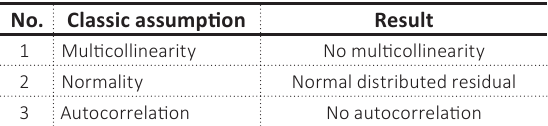
Table 5. Classical assumption test results Source: Processed data